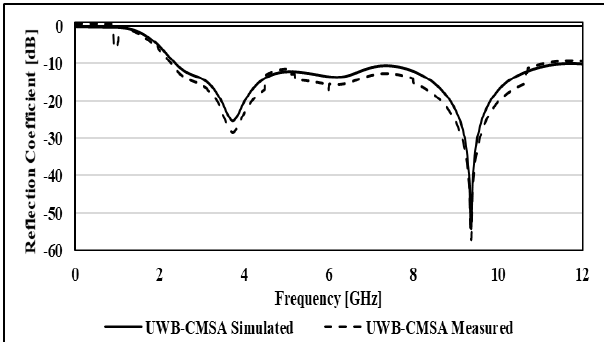
Figure 2. Fabricated UWB-CMSA.